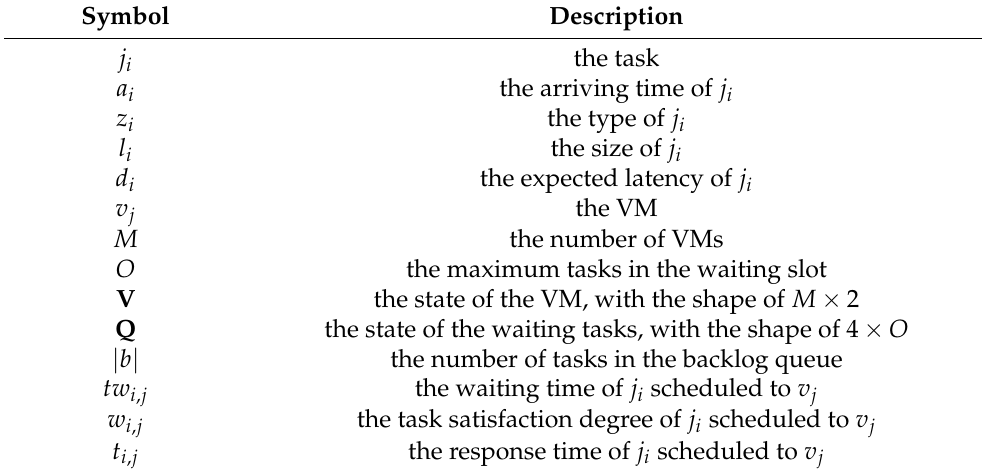
Table 1. List of